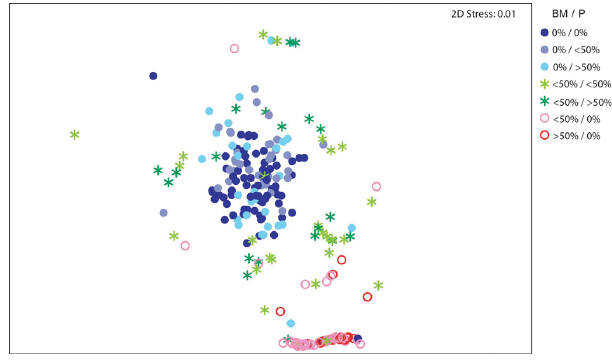
Fig. 4. Similarity between images with combinations of different coverage by bacterial mats (BM) and pogonophorans (P) (MDS plot, transect I).